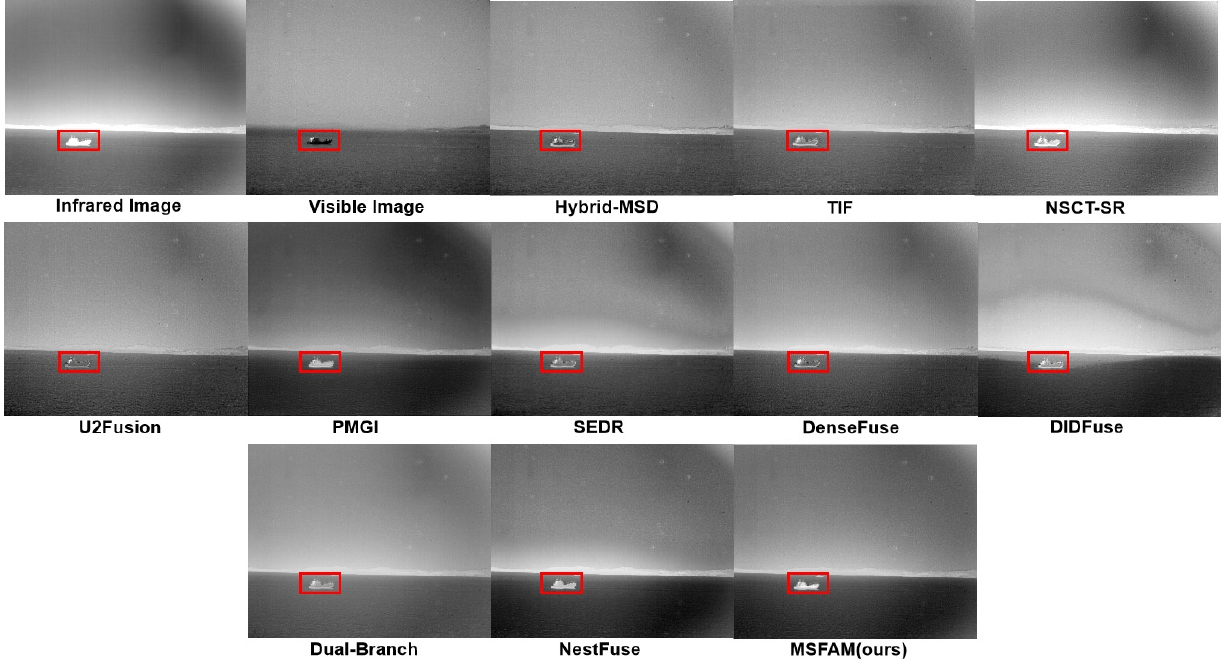
Figure 7. Experimental results of various methods on the “man in doorway” images. Red square represents for the areas that need to be focused.